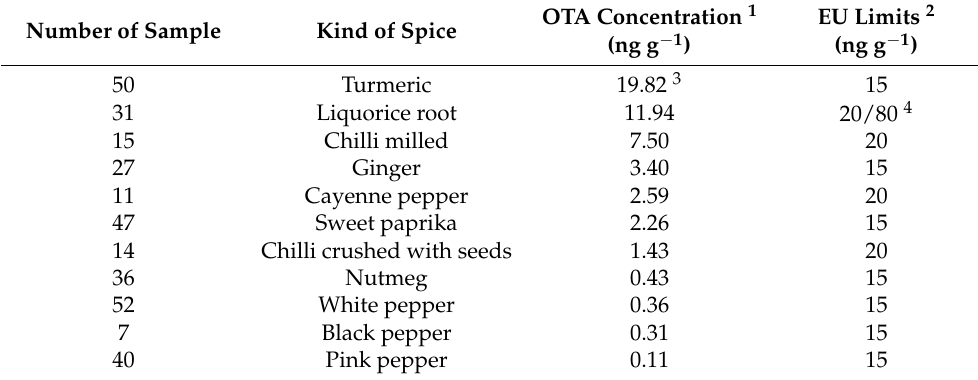
Table 4. The concentrations of OTA in positive single-kind spices available on the Czech market and comparison with the European Union